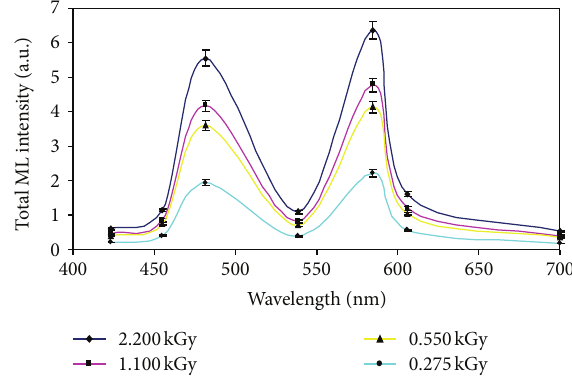
Figure 5: ML emission spectra of MgAl 2 O 4 : Dy (0.1mol%) phos- phor for different gamma-ray dose.